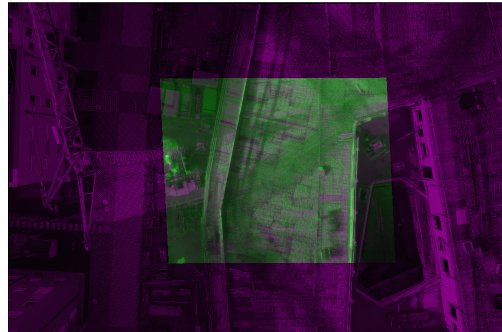
Figure 3. Overlay of RGB image (pink) and coregistered TIR image (green)